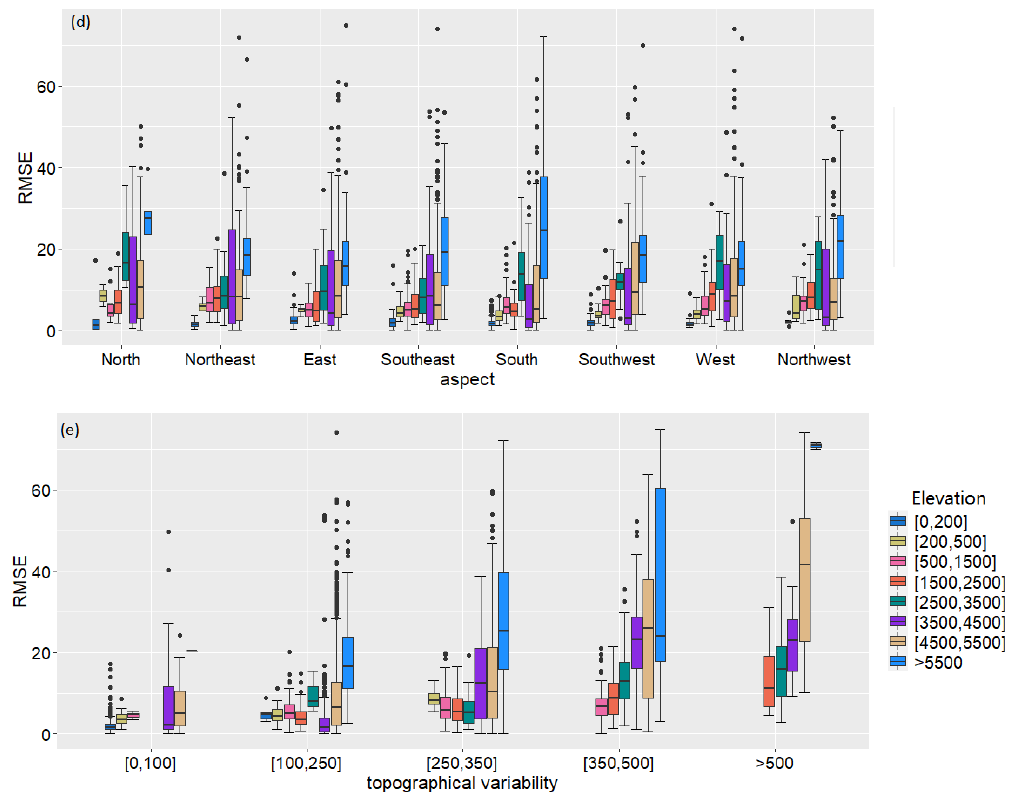
Figure 10. The variations in RMSE dependent on (a) elevation, (b) land cover, (c) slope, (d) aspect, and (e) topographical variability. The different colors refer to the eight different elevation classes. The plots show combined results of P140-R40 and